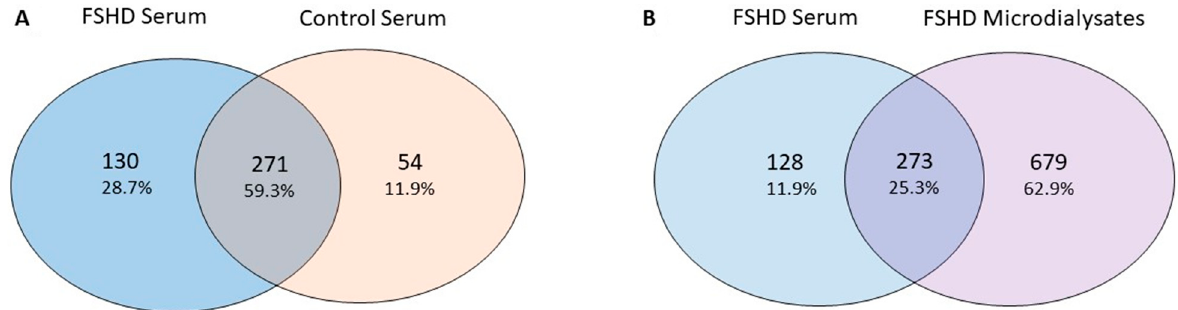
Figure 5. Overlaps of proteins identified in the serum. ( A ) Overlap between proteins identified in FSHD and healthy control sera after albumin and IgG/IgM removal. ( B ) Overlap between proteins identified in FSHD patients’ sera and microdialysates.